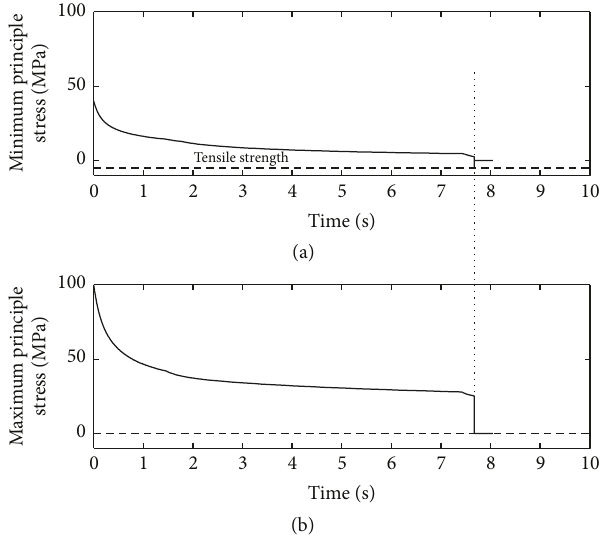
Figure 4: The stress evolution of the reference point in the numerical experiments: (a) the minimum principle stress; (b) the maximum principle stress. The stresses become zero when they reach the extension strength after 7.7